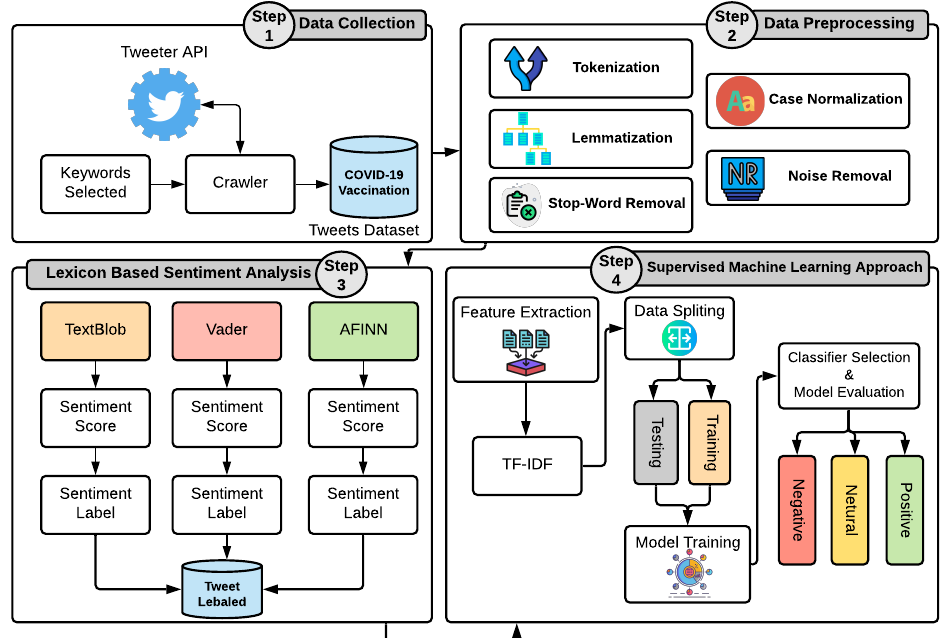
Figure 4. The architecture of the proposed methodology used for sentiment